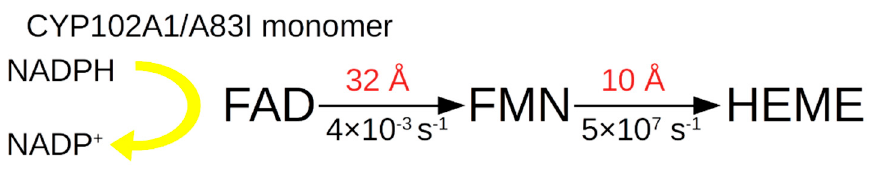
Figure 4. Scheme of electron transport in the electron transport chain of the CYP102A1/A83I mono- mer.